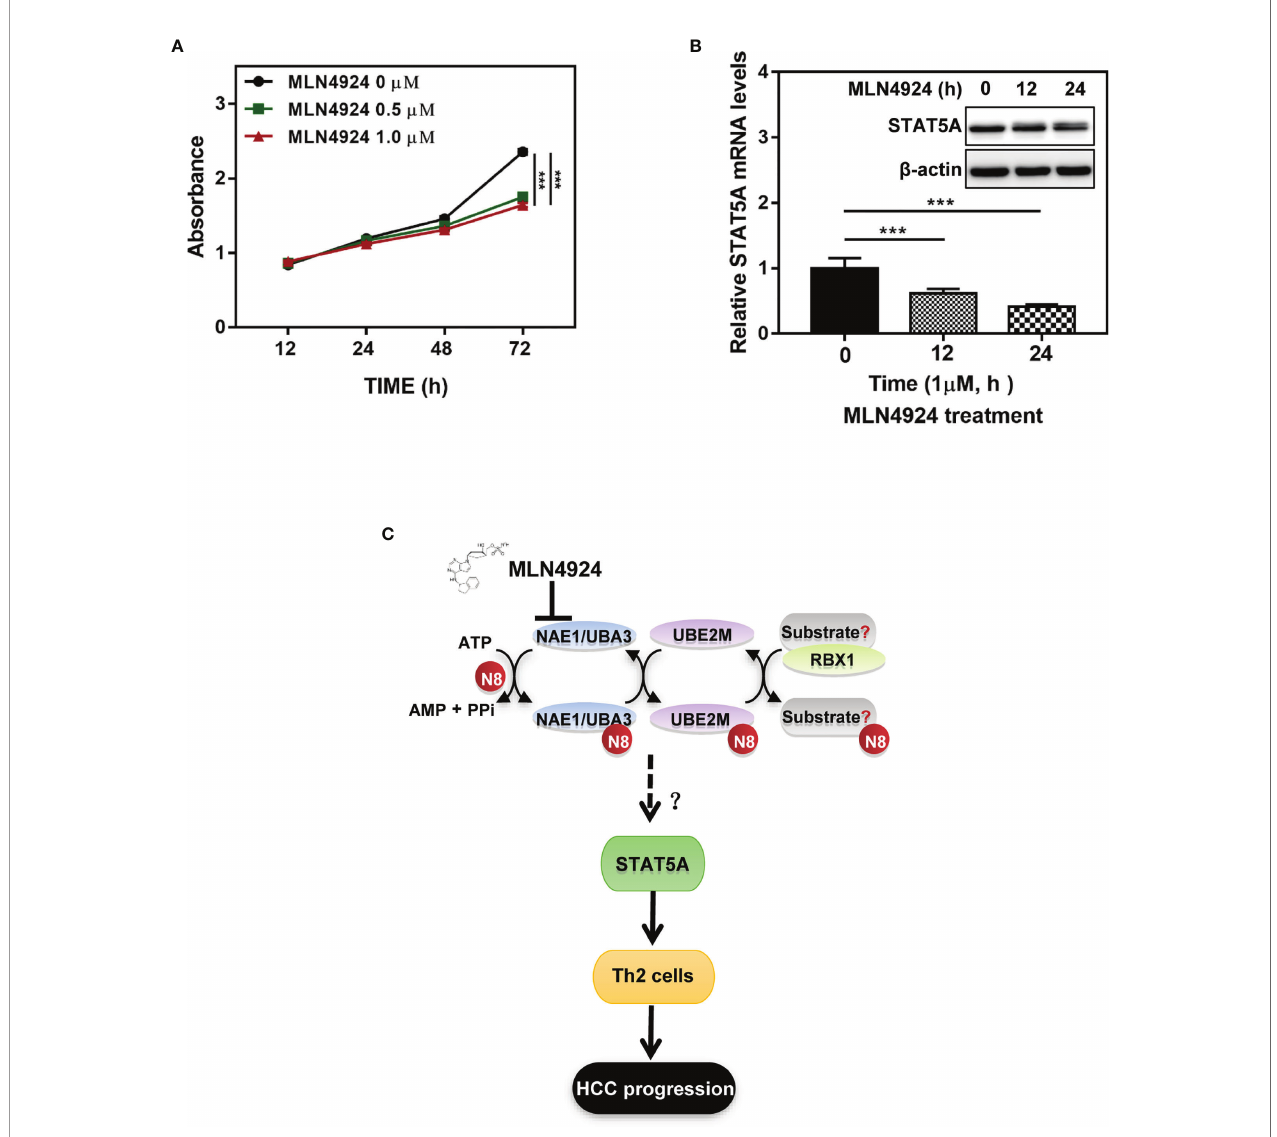
FIGURE 7 | Inactivation of neddylation pathway suppresses the transcription of STAT5A in HCC cells. (A) MLN4924 treatment signi fi cantly inhibited the proliferation of hepatocellular carcinoma cell line Huh7. (B) MLN4924 treatment decreases STAT5A mRNA and protein levels. Huh7 cells were treated with MLN4924 in a time- dependent manner as indicated. (C) Shown is a working model depicting the potential mechanism of neddylation pathway involved in the development of Th2 cells to favor tumor progression. ***P<0.001, for the indicated